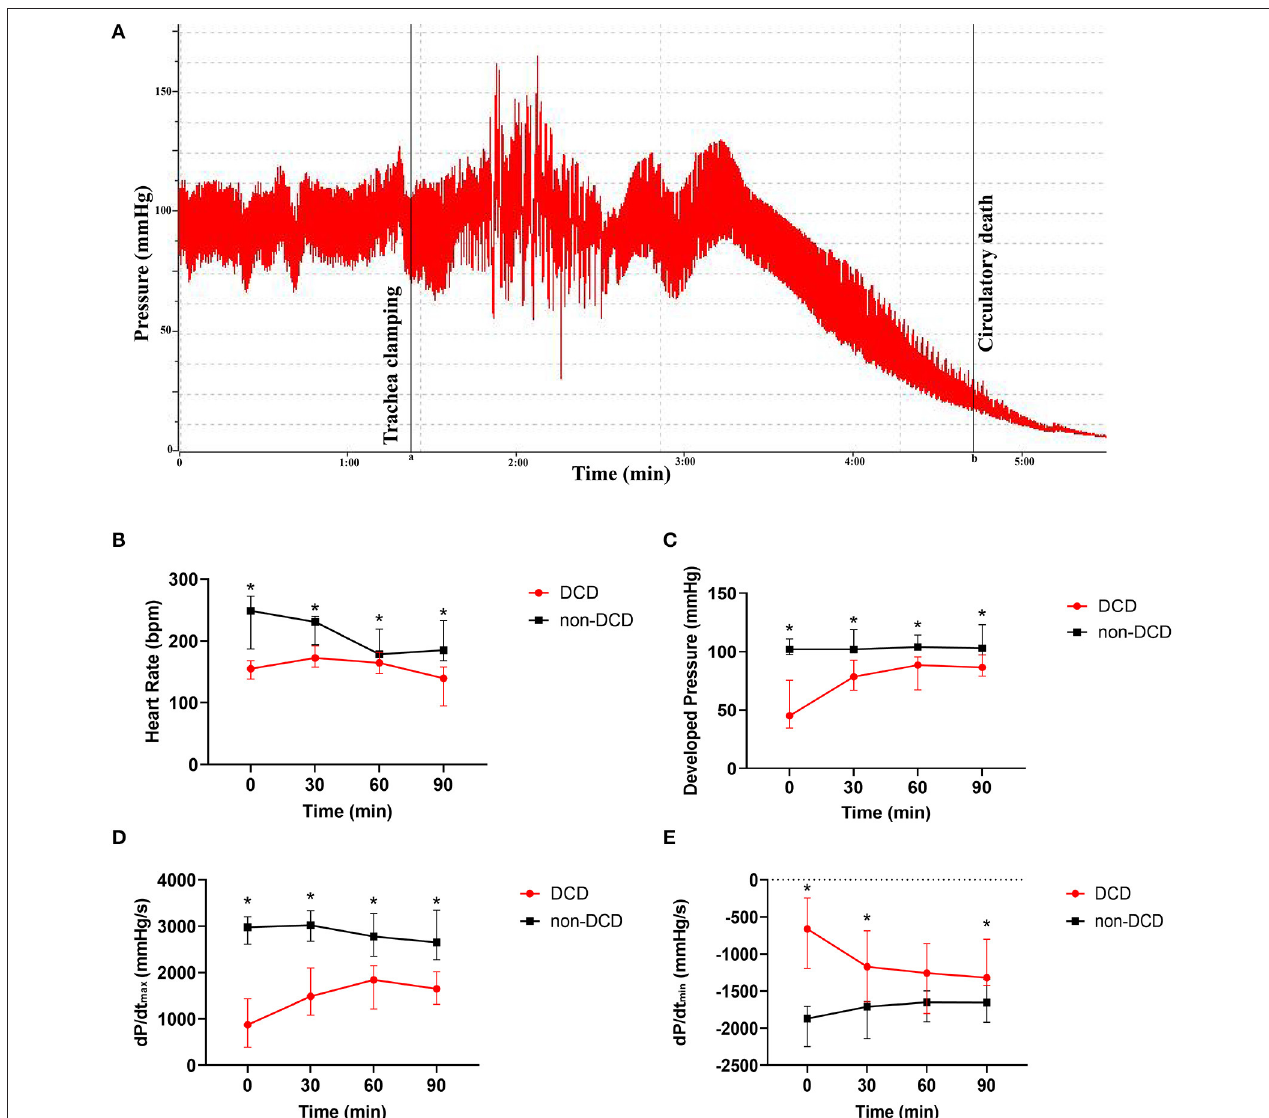
FIGURE 3 | Cardiac functional assessment of the donor heart during ESHP. (A) The typical development process of intracarotid blood pressure of DCD-heart rat following extubation; Line a: the initiation of asphyxiation; Line b: the declaration of circulatory death; (B) Heart Rate; (C) Developed pressure; (D) dP/dt max ; (E) dP/dt min . Data represented as median and interquartile range. n = 8 for each group. DCD, Donation after circulatory death; ESHP, Ex situ heart perfusion; dP/dt max , Maximum rate of rise of left ventricular pressure; dP/dt min , Maximum rate of pressure decline. * p < 0.05 vs. non-DCD